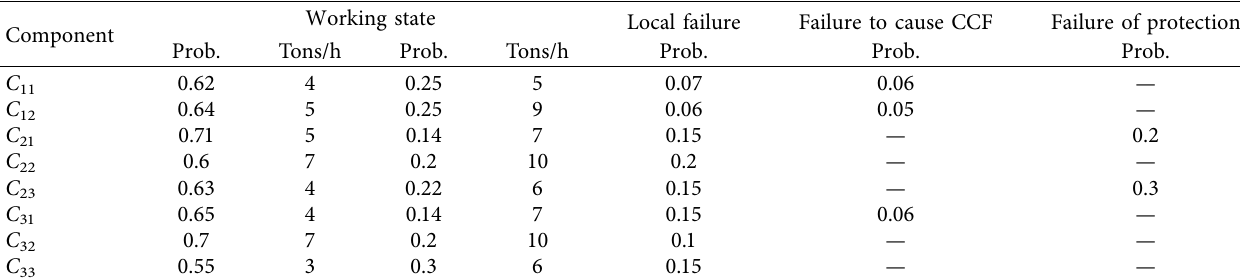
Table 3: Parameters of all the components in the numerical